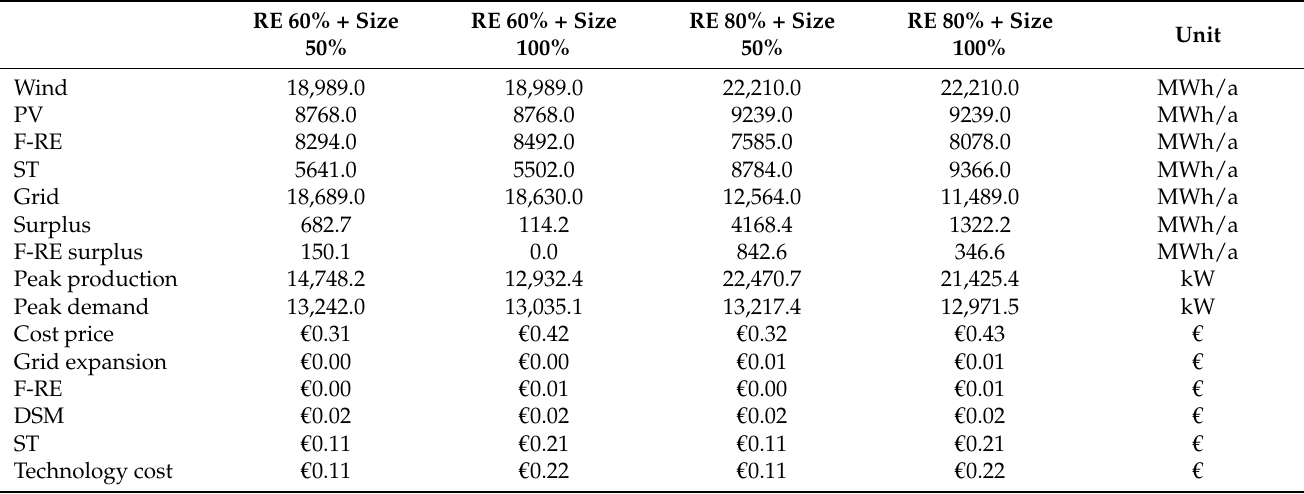
Table A22. Results from the lowered RE production